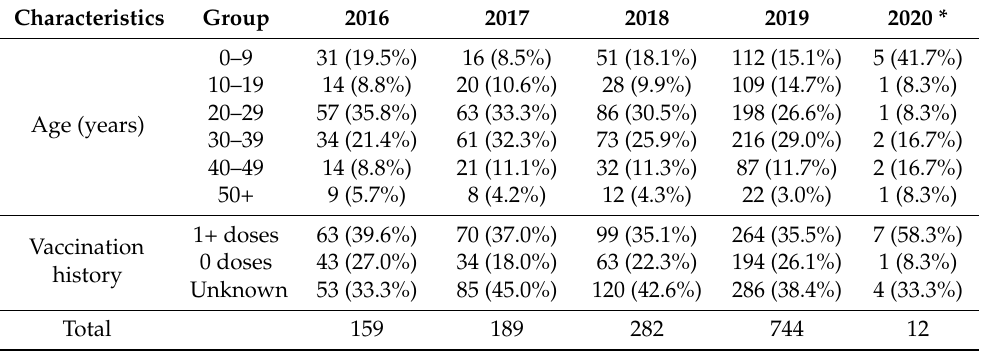
Table 5. Reported measles cases, aggregated by age and vaccination history [16,17,19].